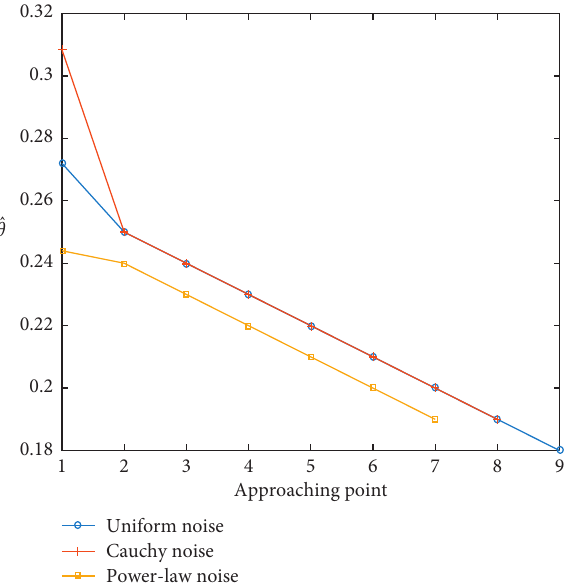
Figure 10: Calibration procedure for complex model.